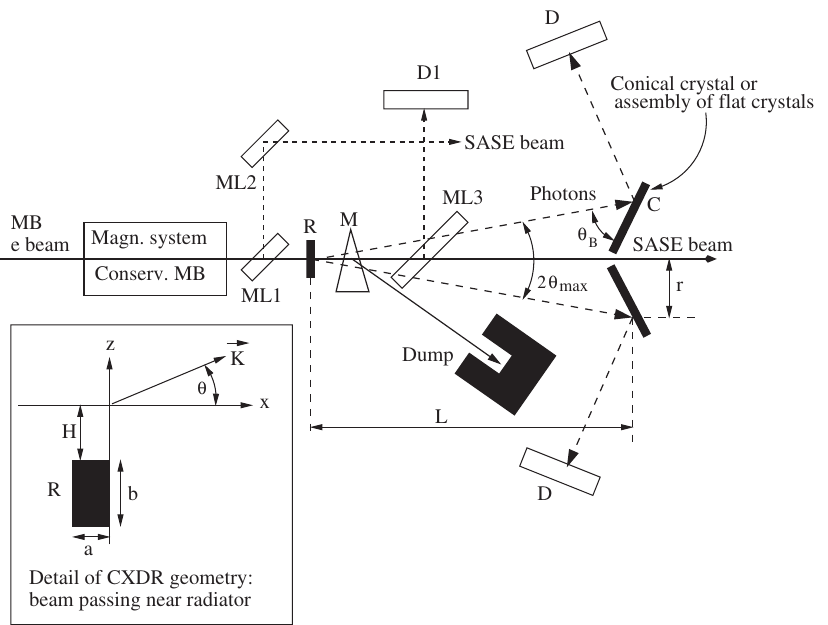
FIG. 3. Possible arrangements for study of CXBR, CXTR, and CXRTR at LCLS. The inset shows details of CXDR